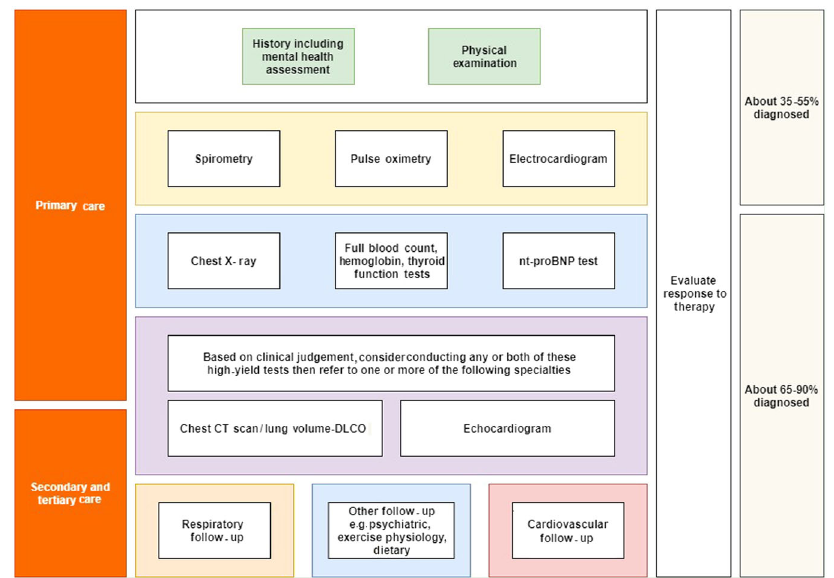
Fig. 2 A summary of the stepwise approach for dyspnoea assessment and the probability of elucidating the causal diagnosis based on the included studies. DLCO diffusing capacity of the lungs for carbon